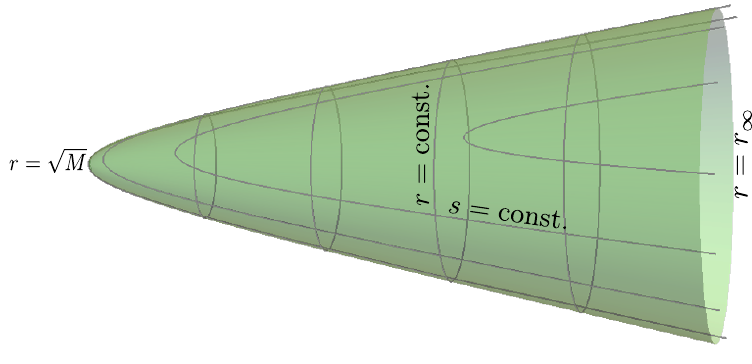
Figure 14 . Surfaces of constant r and s in the Euclidean AdS 3 black brane